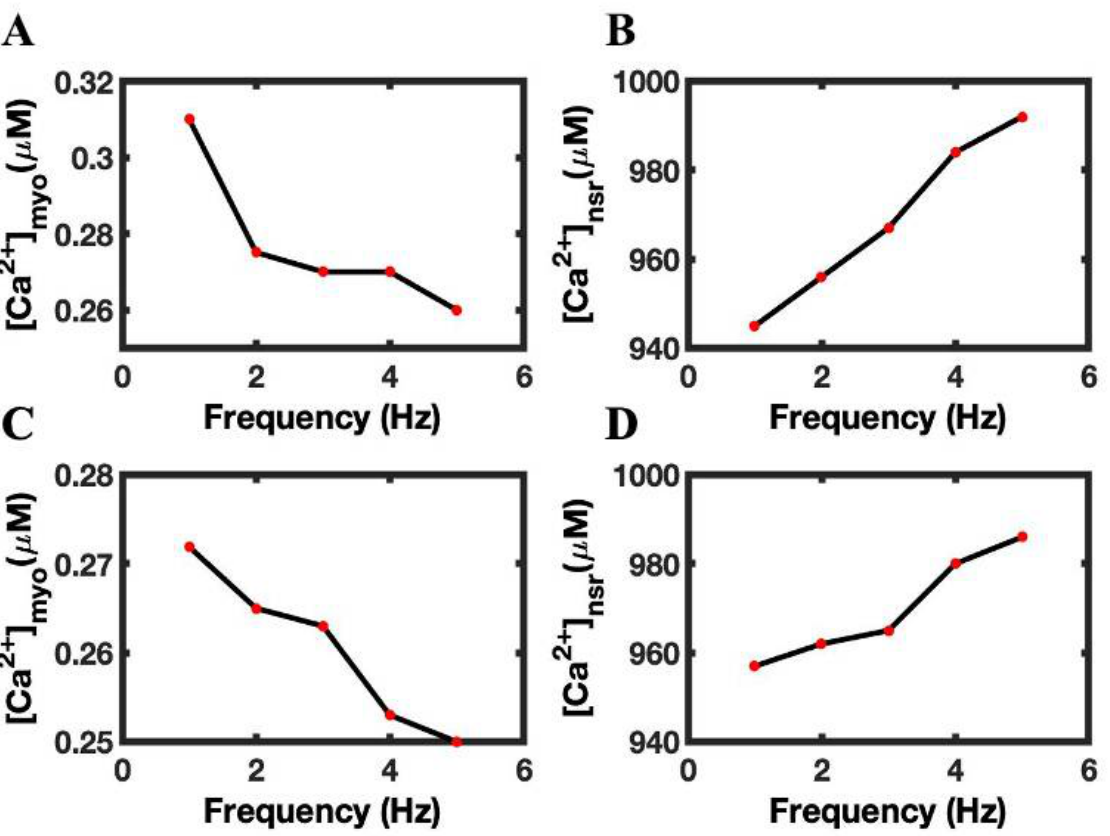
Figure 10. The total myocyte Ca 2+ content is governed by the balance between efflux via the NCX and influx via the L-type Ca 2+ channel. A 25% increase in NCX results in negatively sloped FFR and reduced filling of the SR with pacing: ( A ) Peak myoplasmic Ca 2+ concentration. A 20% reduction in the L-type Ca 2+ channel current results in a negatively sloped FFR and reduced filling of the SR with pacing: ( B ) Peak NSR Ca 2+ concentration. ( C ) Peak myoplasmic Ca 2+ concentration. ( D ) Peak NSR Ca 2+ concentration.